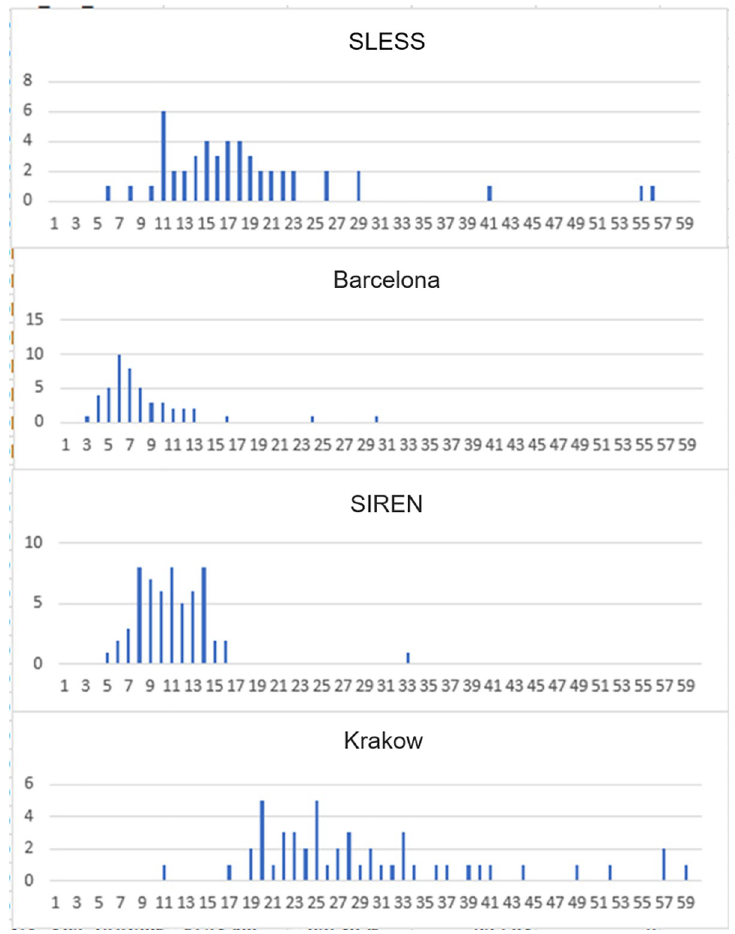
Fig 2. Histogram showing the number of CNV-calls by PennCNV (X-axis) and the number of samples (Y-axis) from 4 CaNVAS centers.